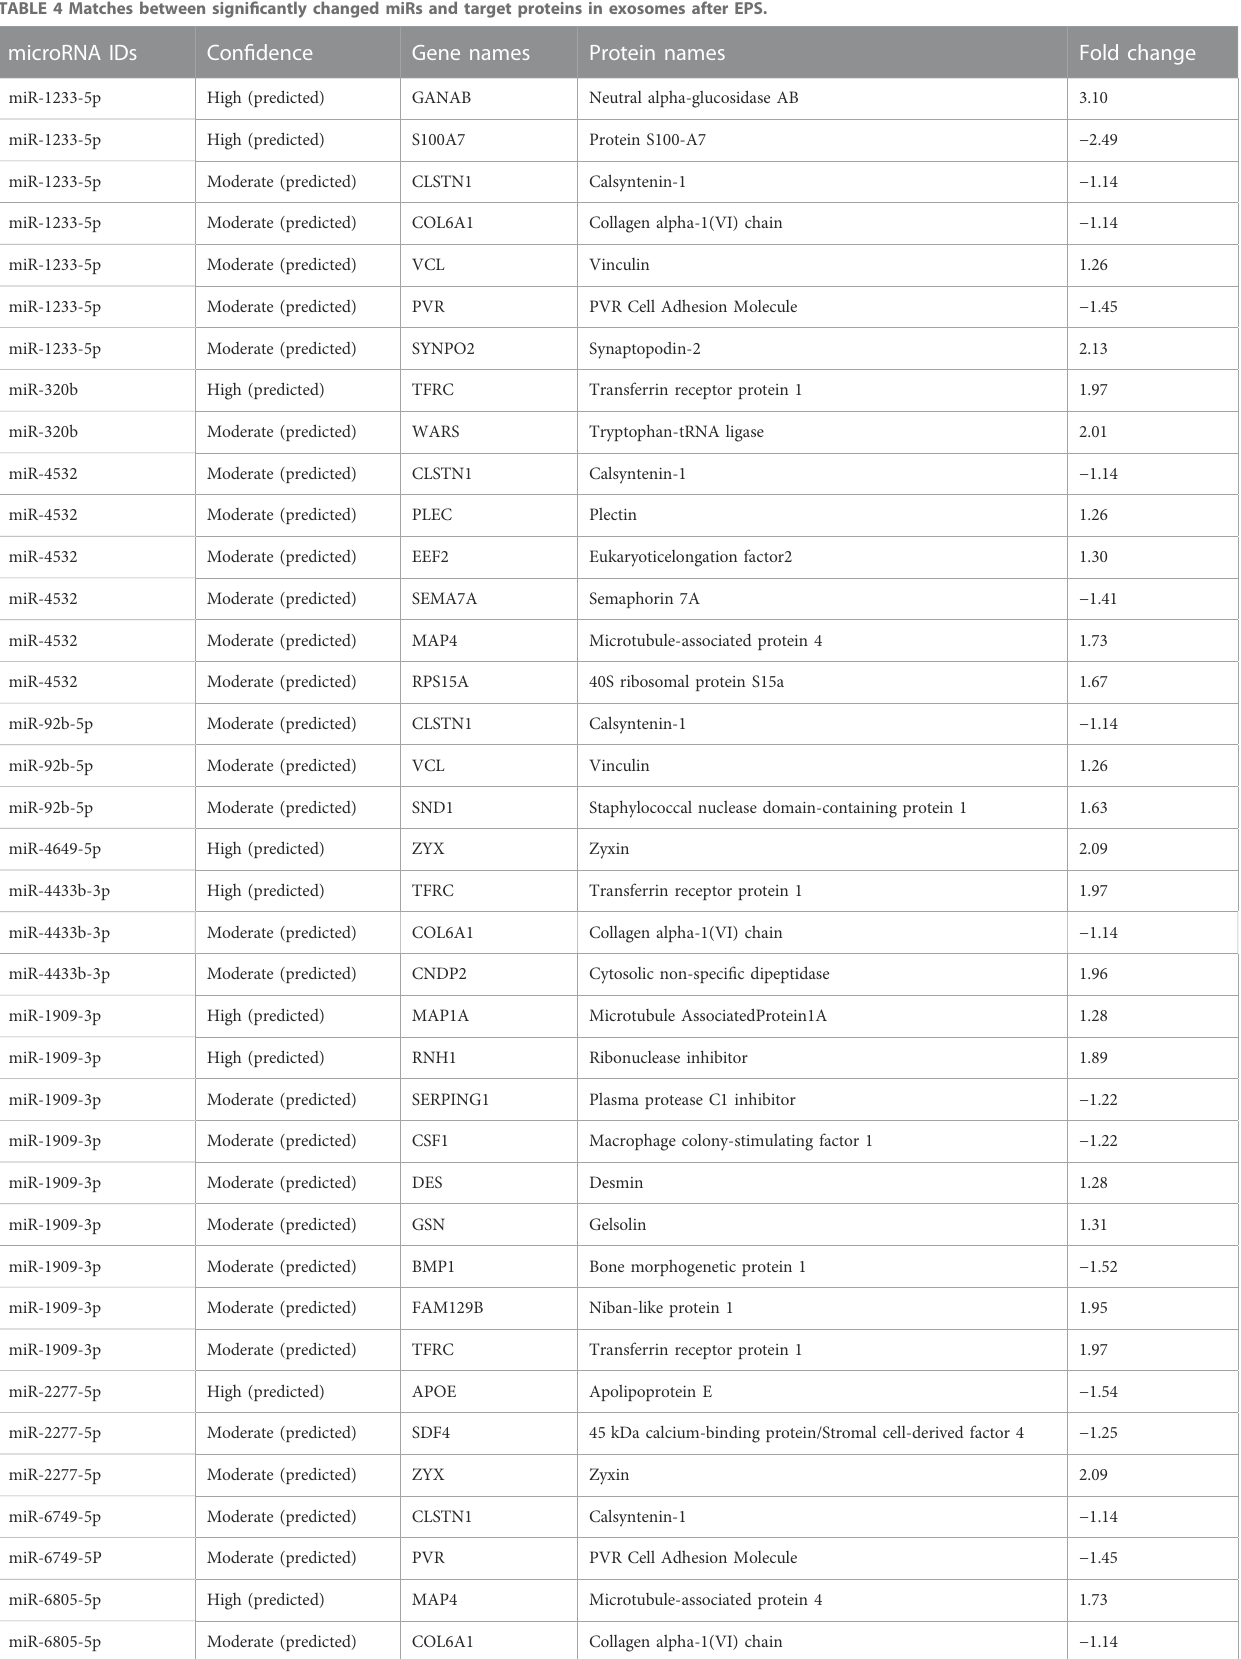
TABLE 4 Matches between signi fi cantly changed miRs and target proteins in exosomes after